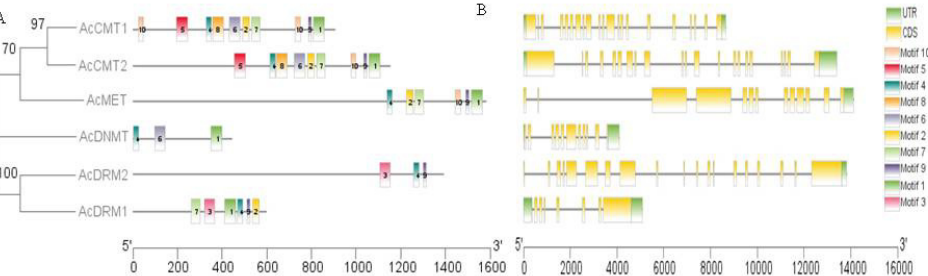
Figure 3. Phylogenetic relationships, conserved motifs, and gene structures of AcC5-MTases. ( A ) Phylogenetic relationships and conserved motifs of CsC5-MTases. ( B ) Gene structures of CsC5-MTases.